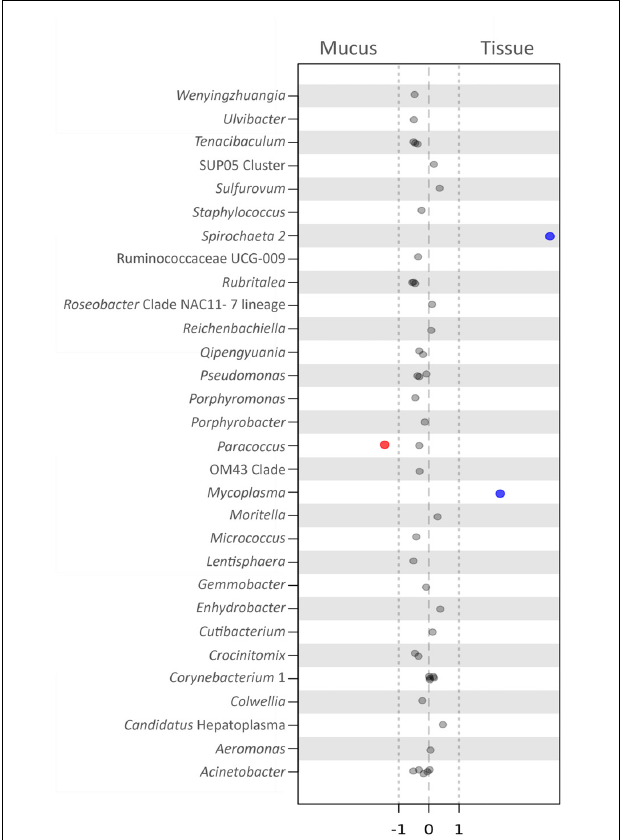
FIGURE 5 | Biomarker analysis of bacteria in Paragorgia arborea compartments. Effect size scores for bacterial OTUs, classified at the genus level, defined as biomarkers through the use of ANOVA-Like Differential Expression (ALDEx) analysis (R package ALDEx2). Significance is determined by effect size, comparing tissue to mucus: values > 1 represent significant, positive associations with tissue (blue), values < –1 show a negative association with tissue and a significant, positive association with mucus (red), and values between –1 and 1 are close to but not significant. Each dot represents an OTU (within the specified genus) tested as a biomarker. The 30 OTUs (having assigned genera) with effect sizes closest to significance are shown